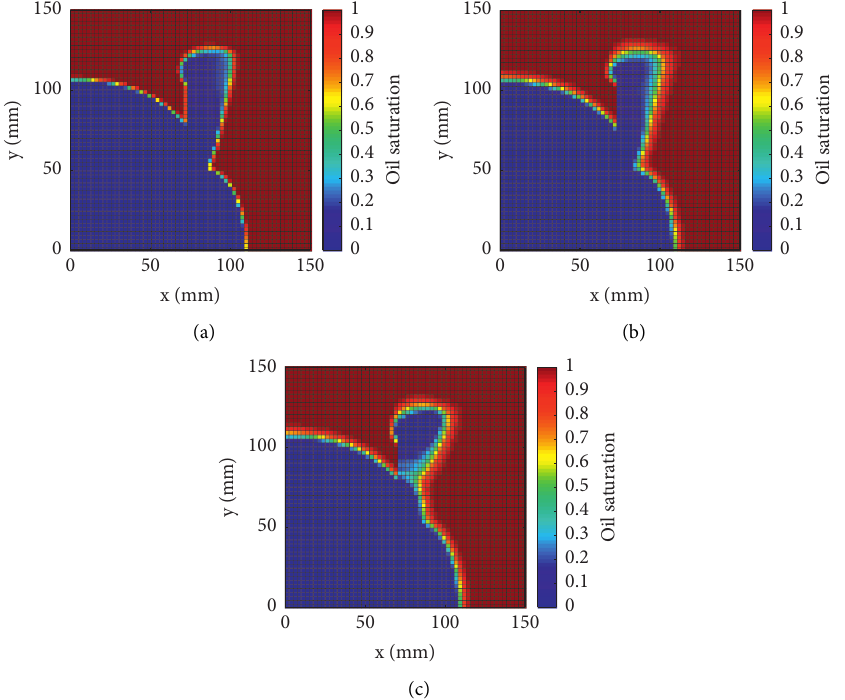
Figure 13: Oil saturation profiles after mesh refinement for (a) upscaled fine grid simulation, (b) pIEDFM, and (c) EDFM after 1800seconds of